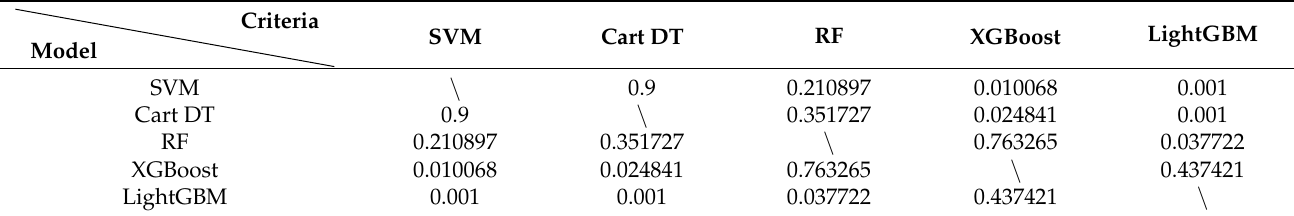
Table 7. The Friedman test p -value matrix under criterion